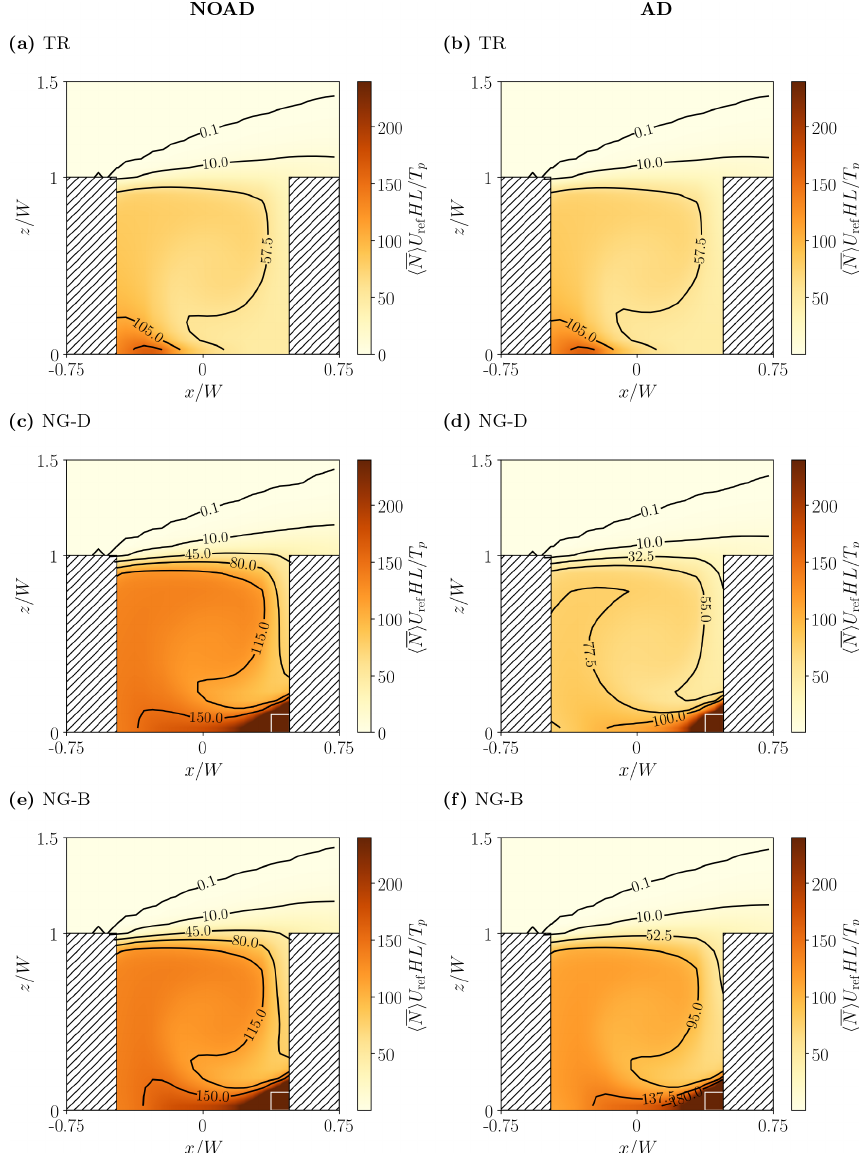
Figure 6. Normalised mean aerosol number concentration, (cid:104) N ∗ (cid:105) , for different emission scenarios: (a, b) traffic (Case TR); (c, d) near-ground, deep-frying (Case NG-D); (e, f) near-ground, boiling (Case NG-B). Results without (NOAD) and with (AD) aerosol dynamic processes are shown at the left and right, respectively. The approximate position of the roadside restaurants is indicated by the white lines (which are shifted for